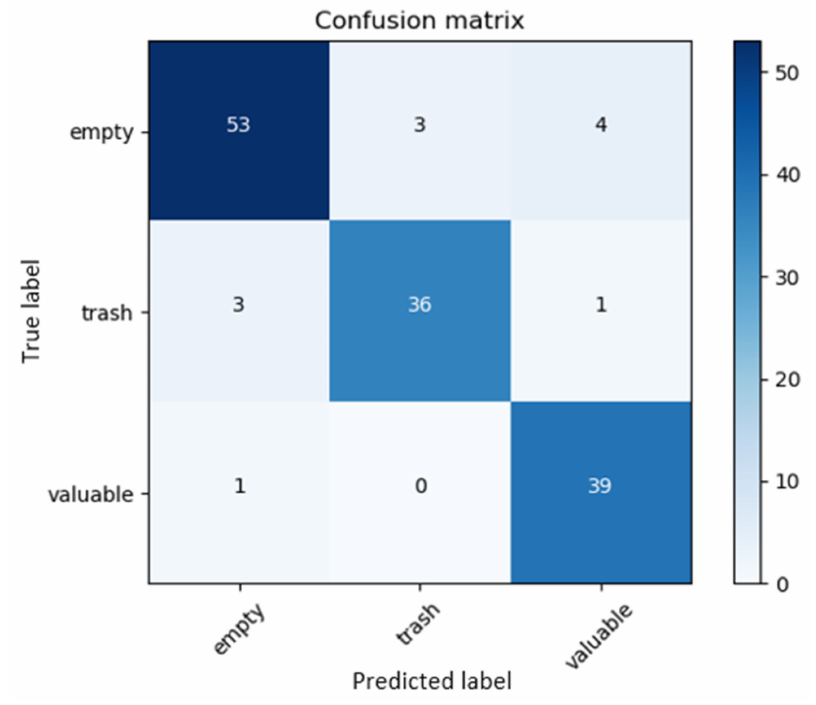
Figure 8. Confusion matrix for the test